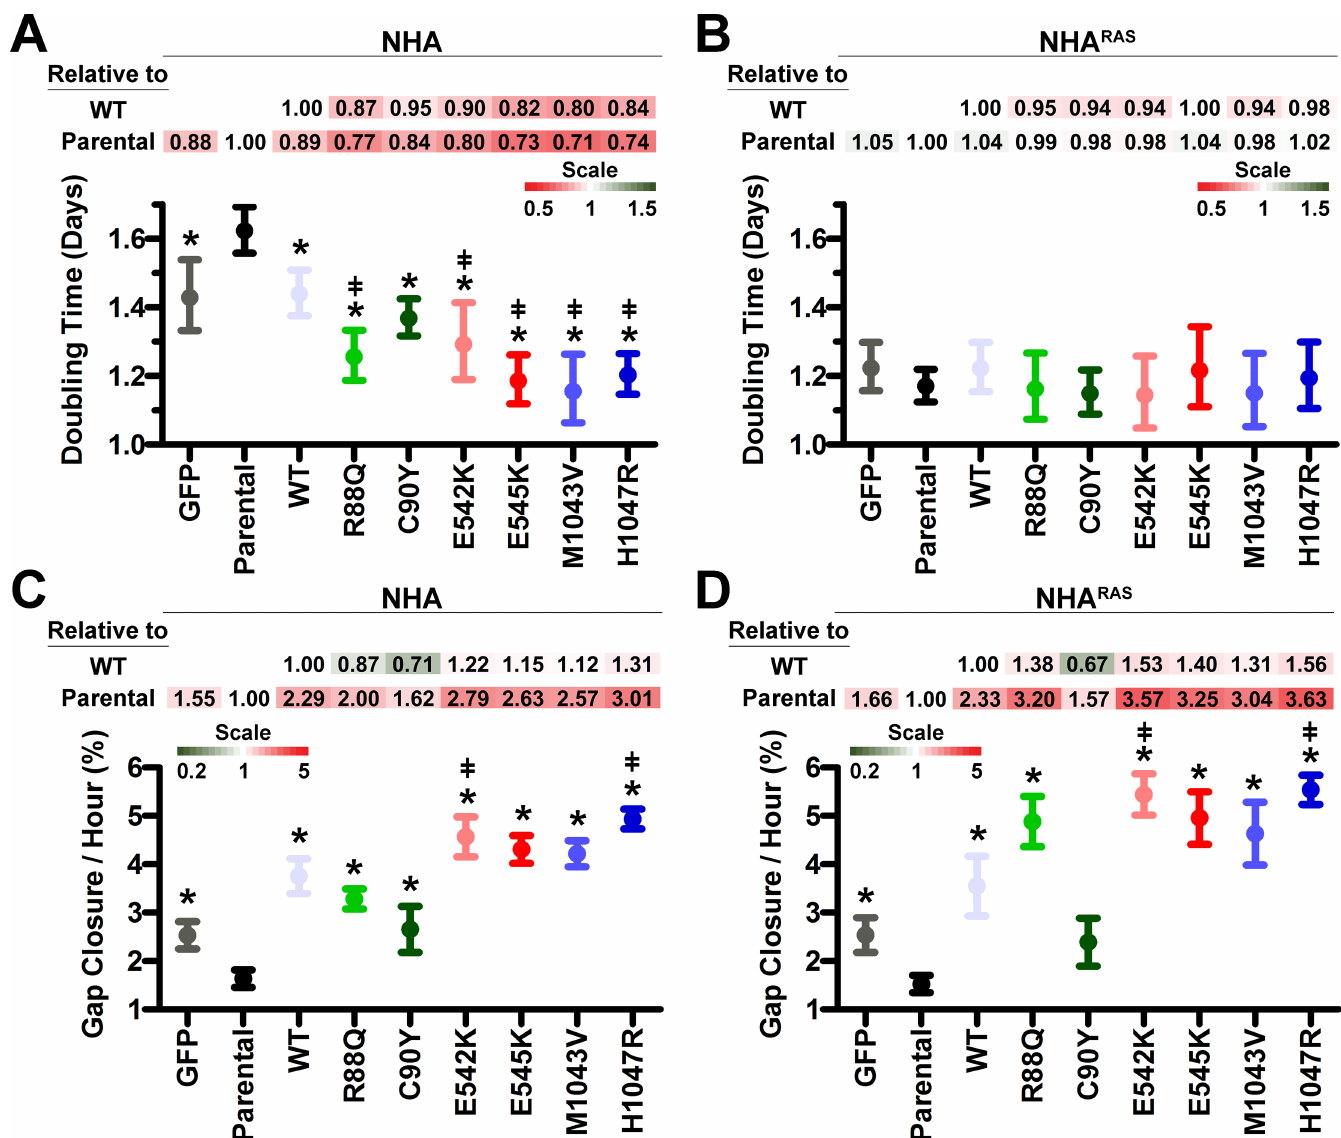
Fig 2. PIK3CA mut potentiate proliferation and migration in vitro . MTS assays showed that PIK3CA WT and all PIK3CA mut decreased doubling times of NHA ( A ), but not NHA RAS ( B ) ( (cid:3) , P (cid:20) 0.02 vs parental, S5A and S5B Fig ). PIK3CA mut , except C90Y, decreased doubling times compared to PIK3CA WT NHA ( ‡ , P (cid:20) 0.03). Growth rates were analyzed by comparing k values. Error bars are 95% confidence intervals. PIK3CA WT and PIK3CA mut , except C90Y, increased migration of both NHA ( C ) and NHA RAS ( D ) ( (cid:3) , P (cid:20) 0.04, S5C and S5D Fig ). E542K and H1047R also potentiated migration compared to PIK3CA WT NHA and NHA RAS ( ‡ , P (cid:20) 0.005). Fold changes in doubling times and migration rates relative to parental and PIK3CA WT lines are shown as